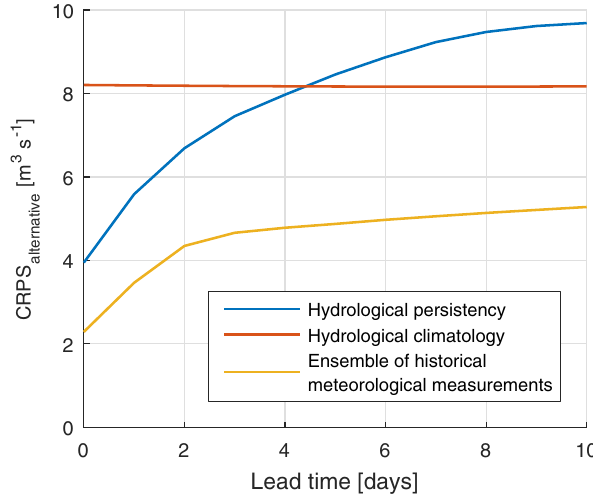
Figure 3. CRPS of three alternative forecast sets, evaluation period